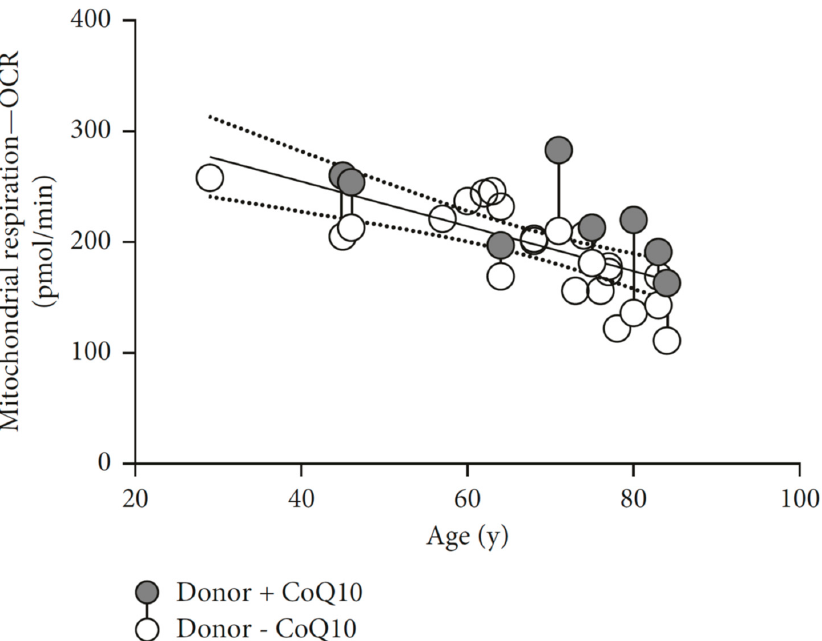
Figure 3. Age-related decline in the oxygen consumption rate in epithelial tissue measured 16 hours after collection in a Seahorse XF analyzer. The gray circles show treated samples, the white circles untreated samples, and the connected circles represent samples from the same donor. Significant improvement with 100 μ M CoQ 10 incubation. (Adapted from Schniertshauer et al. 2018 [70] with permission).